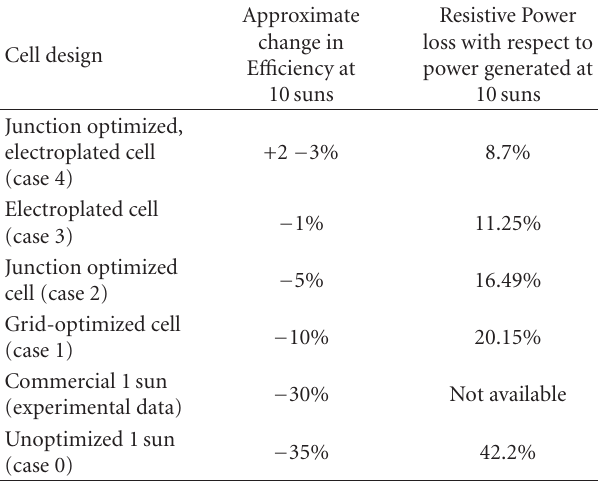
Table 2: Summary of results of cell